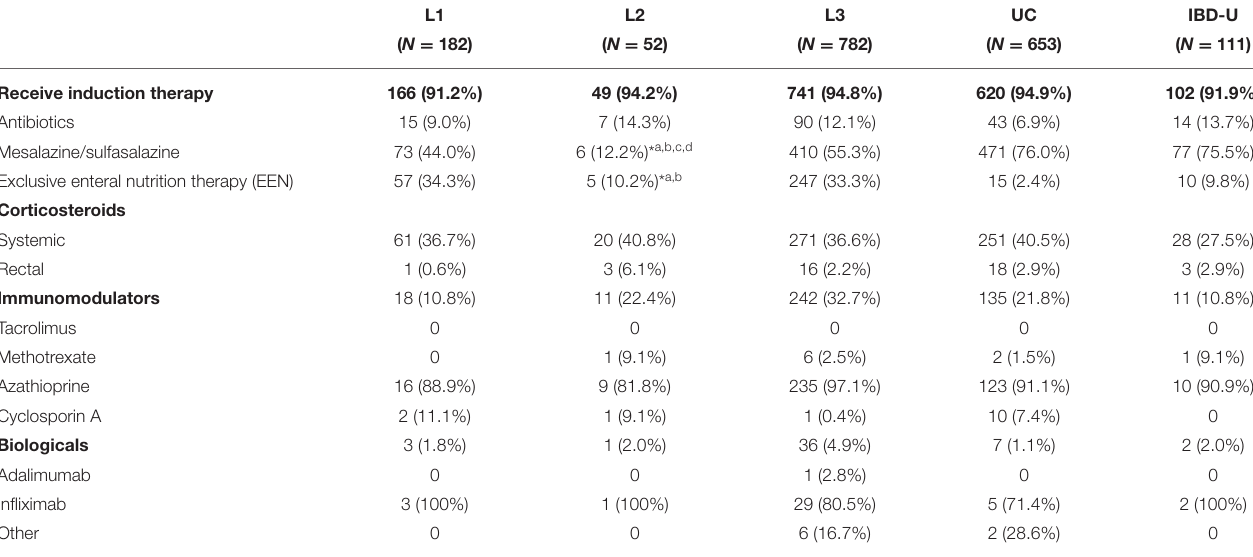
TABLE 3 | Induction therapy after diagnosis according to the disease